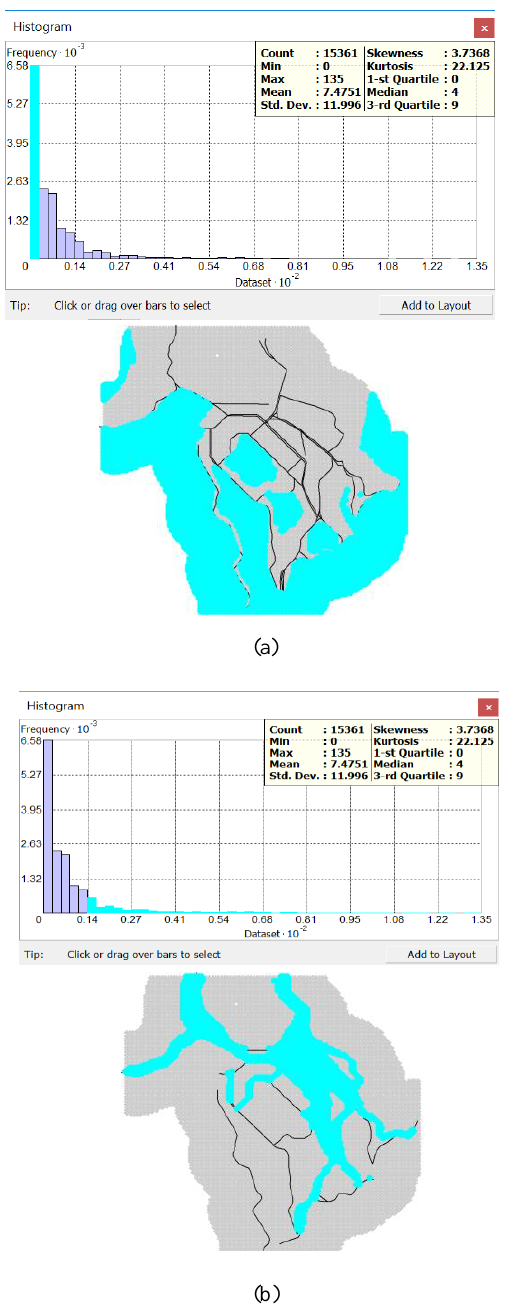
Figure 5. Histograms linked with the spatial data showing least (a) and high (b) PM 10 concentrations